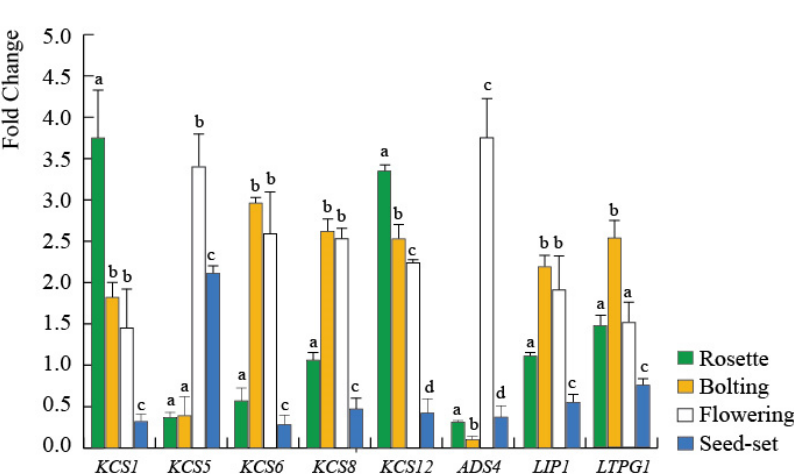
Figure 3. Time-course expression of genes in Arabidopsis thaliana exposed to NNMF conditions. Values are expressed as fold change with respect to control plants growing in GMF conditions. Bars represent standard deviation. Age of plants was the same as reported in figures 1 and 2. For the same gene, different letters indicate significant ( p < 0.05) differences between the different plant developmental stages.